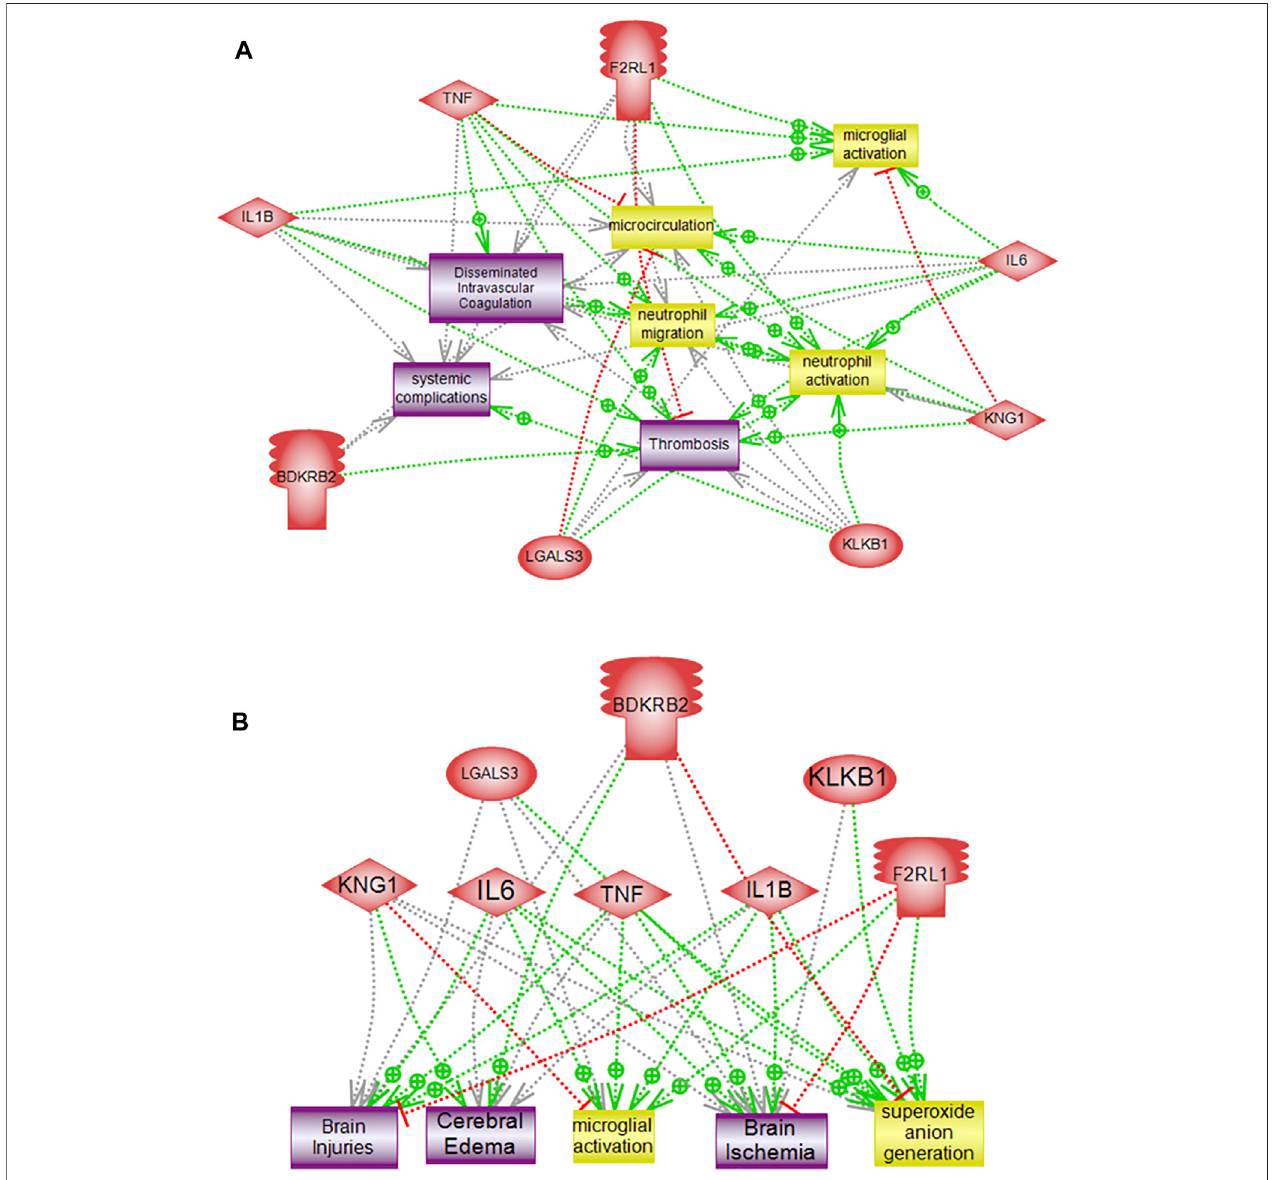
FIGURE 7 | Pathway analysis of altered genes demonstrating direct functional interactions interactome networks in microglial cells. (A) Systemic related interactome, (B) Brain-related interactome. F2RL1 (Protease-activated receptor 2), IL-6 (Interleukin-6), KNG1 (Kininogen), KLKB1 (PKall), LGALS3 (Galectin-3), B 2 KR (Bradykinin 2 receptor), IL-1B (Interleukin-1 β ), TNF- α (Tumor necrosis factor- α ), COX2 (cyclooxygenase2), LPS (Lipopolysaccharide).